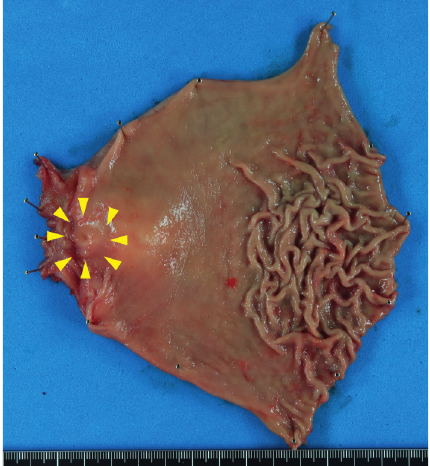
Figure 2: Macroscopic findings of the distal gastrectomy specimen. The lesion was located in the gastric antrum, and duodenum and was 3.7cm